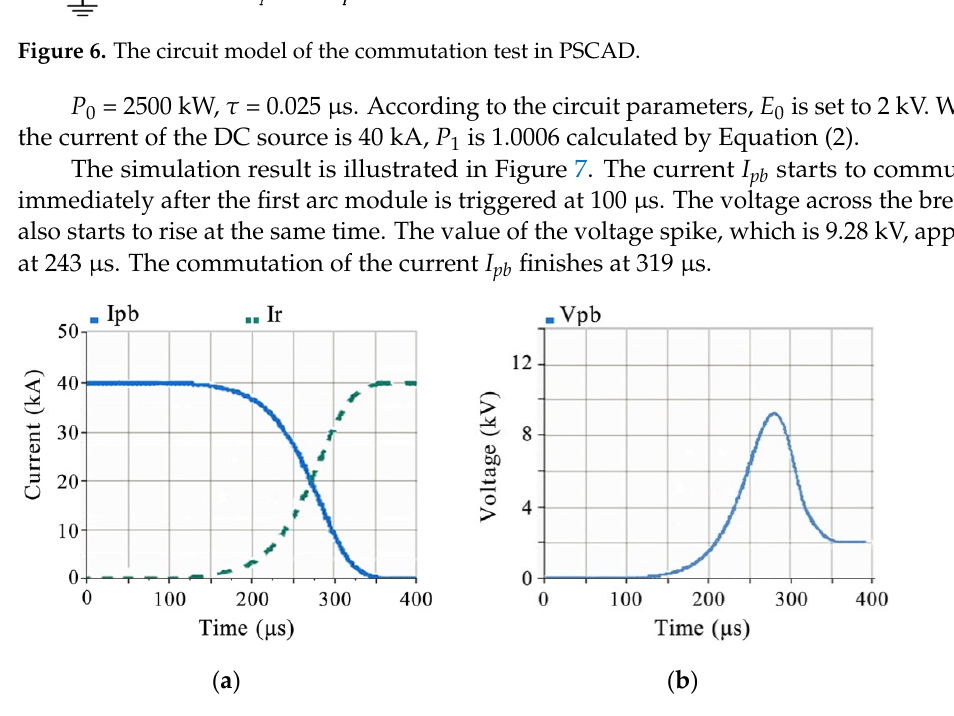
Figure 7. Simulation results of the pyro-breaker at 40 kA: ( a ) Current oscillogram; ( b ) Voltage os-